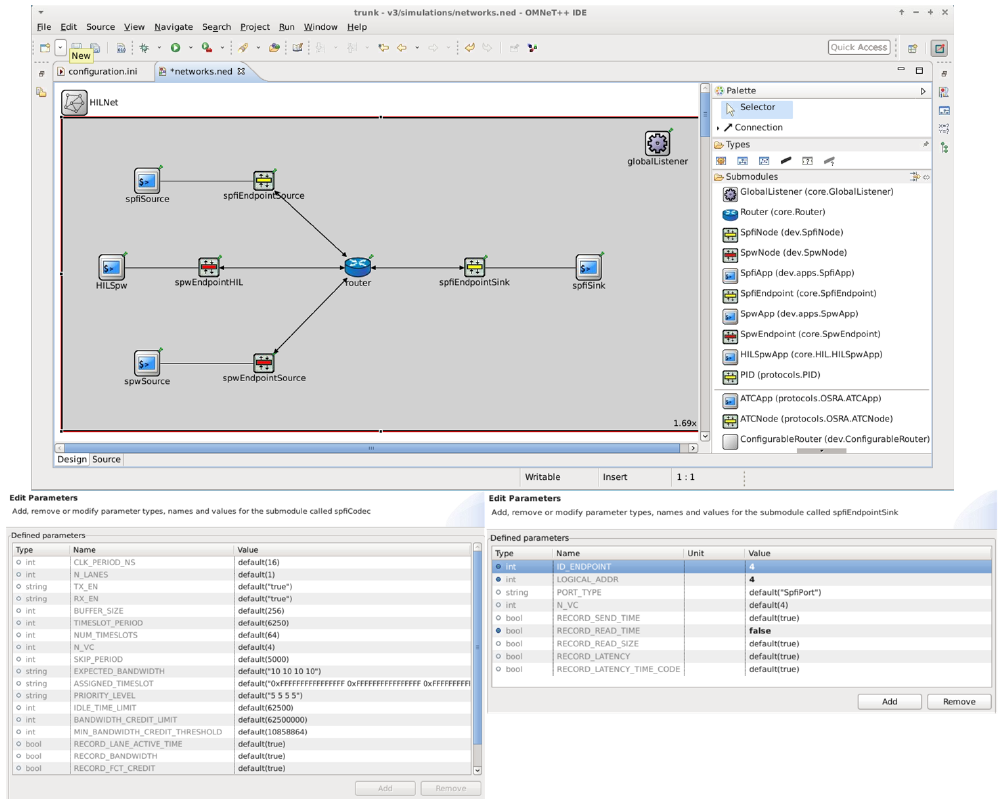
Figure 9. Network setup and parameter configuration for a SpaceFibre endpoint and its internal Compression/Decompression module